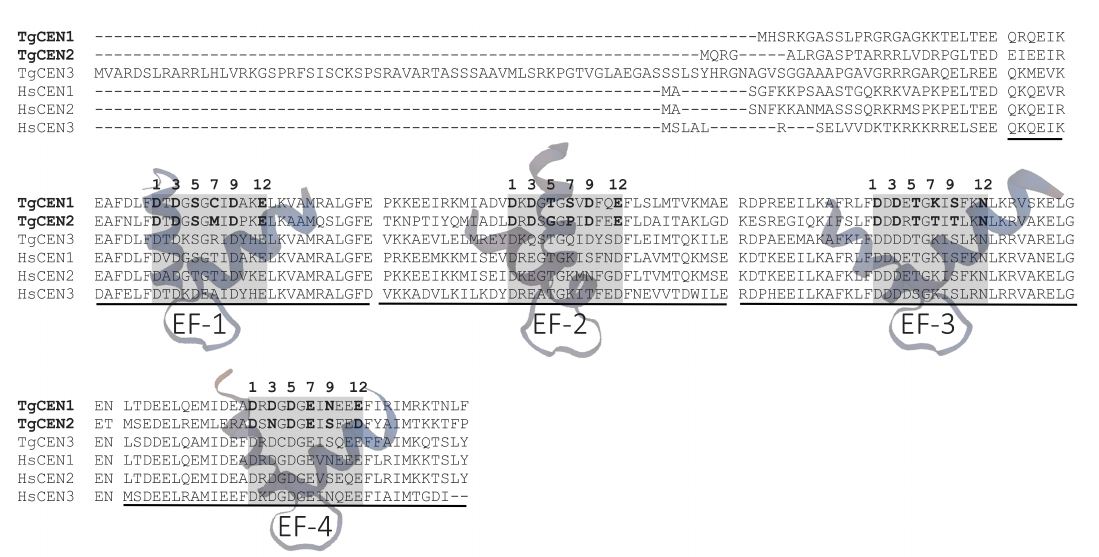
Figure 1. Multiple sequence alignments of TgCEN1 and TgCEN2 with other members of the centrin family. Residues critical for Ca 2 + coordination (positions 1, 3, 5, 7, 9, and 12) in EF hands are shown in bold. TgCEN1 ( T. gondii CEN1, UniProt: A0A125YHX7), TgCEN2 ( T. gondii CEN2, UniProt: A0A125YZN2), TgCEN3 ( T. gondii CEN3, UniProt: A0A125YXG1), HsCEN1 ( H. sapiens CEN1, UniProt: Q12798), HsCEN2 ( H. sapiens CEN2, UniProt: P41208), HsCEN3 ( H. sapiens CEN3, UniProt: O15182). Sequences were aligned using Clustal Omega